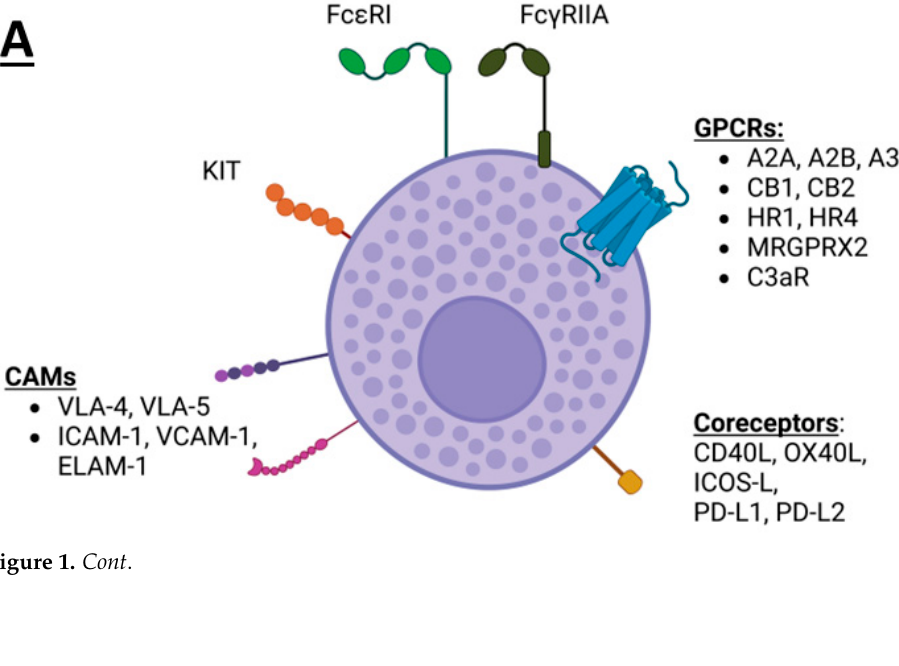
Figure 1. Several types of receptors and coreceptors are present on the mast cell surface ( A ) and upon MCs activation, various mediators of the early and late phases are released ( B ). Figure created with BioRender.com. Mast cell degranulation can be monitored via various assays, including ELISA tests, flow cytometry, or colorimetric assays. ELISA tests are popular in the case of cytokines, chemokines, growth factors, and proteins, but as they use antibodies, the procedure is rather long. With flow cytometry, three approaches to detect mast cell degranulation pre- dominate: detecting the appearance or upregulation of surface biomarkers (e.g., CD63 and CD107a), measuring changes in the mediator content (like histamine, chemokine (C-C mo- tif) ligand 4, (CCL4), and chemokine (C-X-C motif) ligand 8 (CXCL8)), and staining of intracellular calcium ions. To enable the detection of degranulating cells in this method, fluorescently labeled antibodies or other labeled compounds with fluorochromes must be applied [8]. The colorimetric assays are easier, quicker, and can be applied for the most common mediators monitored during mast cell degranulation such as histamine, β -hex- osaminidase ( β -hex), or tryptase. However, the half-life of histamine released from cells is very short, thus its determination may not be as accurate [9] as the measurement of β - hexosaminidase and tryptase. To gain the information upon occurring mast cell degranu- lation, the release of a selected mediator to the supernatant is compared to the concentra- tion of the mediator in the cell lysate. The main difference between these methods is asso- ciated with the amount of received information about the degranulating cells. The flow